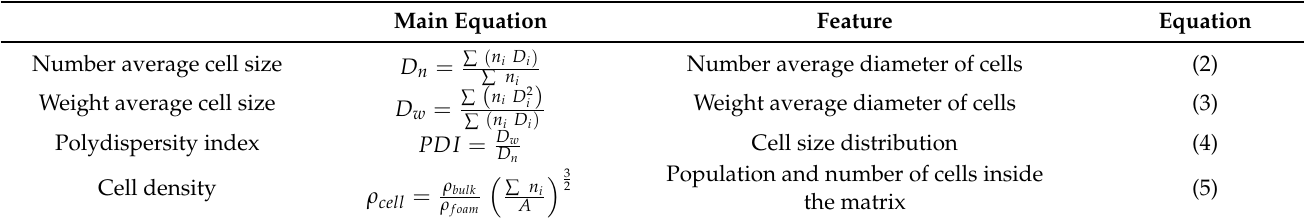
Table 2. The equations and features of the morphological characteristics